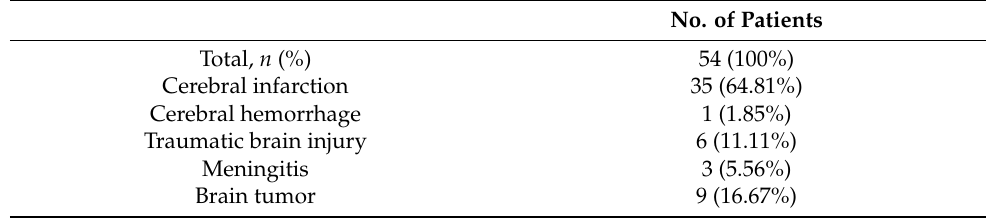
Table 3. Classification of patients with brain-lesion-induced